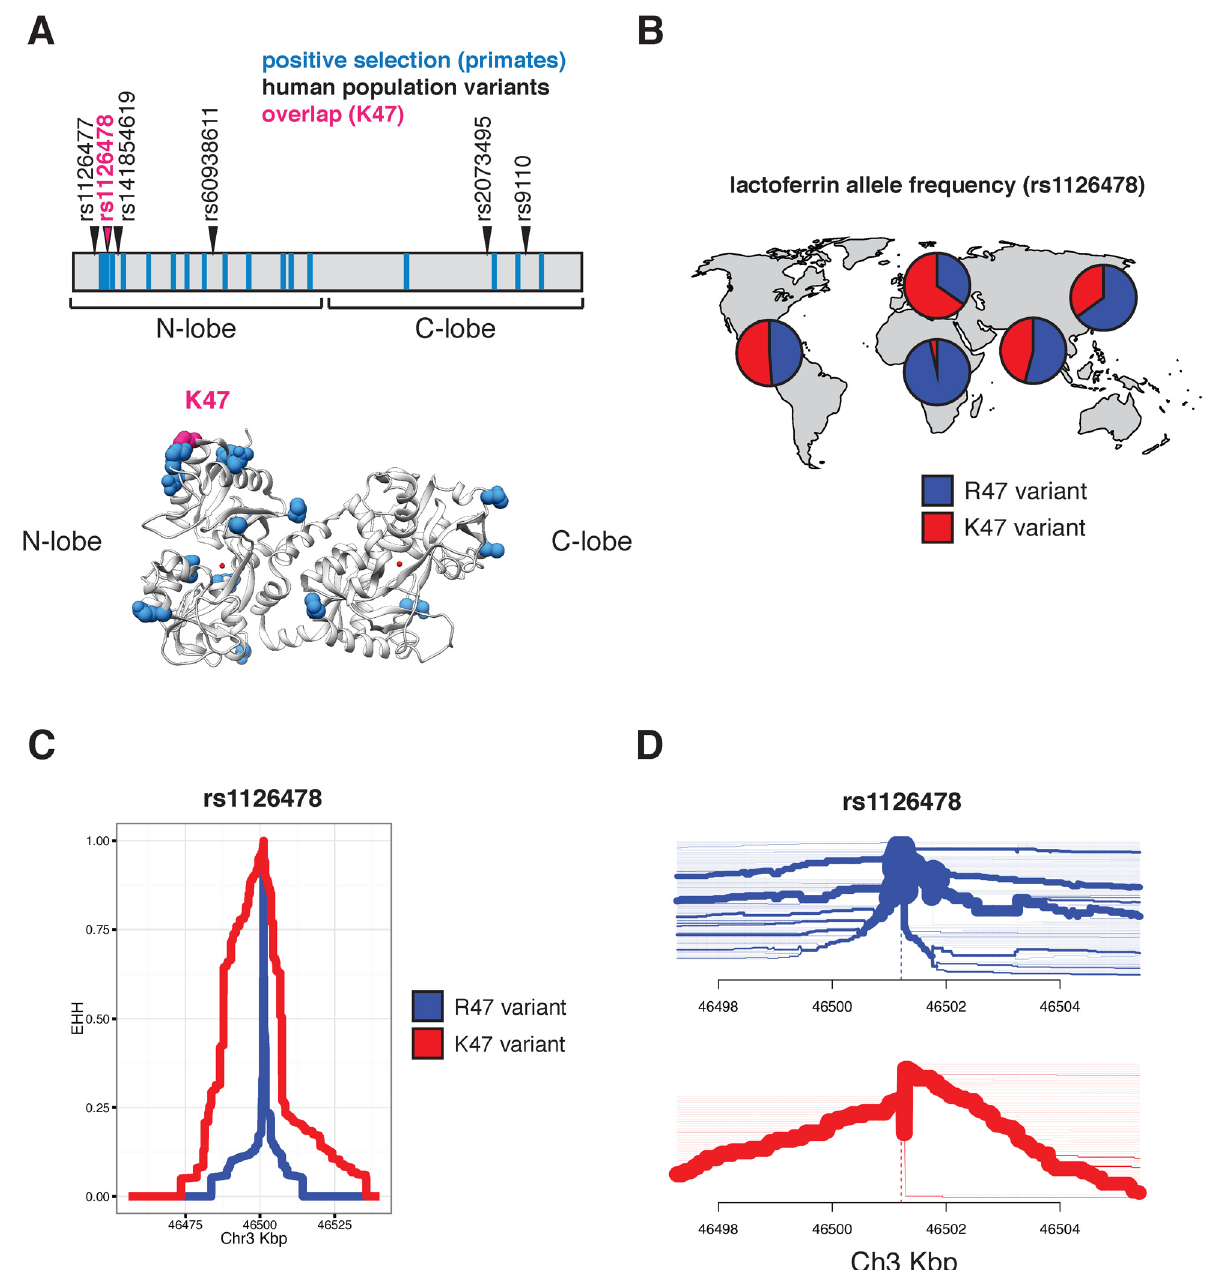
Fig 2. Diversity and evolution of human lactoferrin. A. Schematic representation of the lactoferrin protein showing positions of abundant ( > 1% allele frequency) nonsynonymous polymorphisms found in humans (arrows). Sites previously identified under positive selection across primates are shown as blue bars. The position of one variant, rs1126478 at amino acid position 47, which is also rapidly evolving in primates, is shown in magenta. The position of lysine 47 (K47) is also shown in the lactoferrin crystal structure (bottom panel). B. Relative allele frequencies of the R47 (blue) and K47 (red) lactoferrin variants shown as pie charts across human populations. Data were obtained from the 1000 Genomes Project Phase III. C. Extended haplotype homozygosity (EHH) plot around the lactoferrin for the R47 (blue) and K47 (red) around the variable position site, showing the extended haplotype around the K47 variant. D. Haplotype bifurcation plot showing breakdown of linkage disequilibrium in individuals carrying the lactoferrin R47 (blue) and K47 (red) alleles around the variant position. Thickness of the line corresponds to the number of individuals with shared